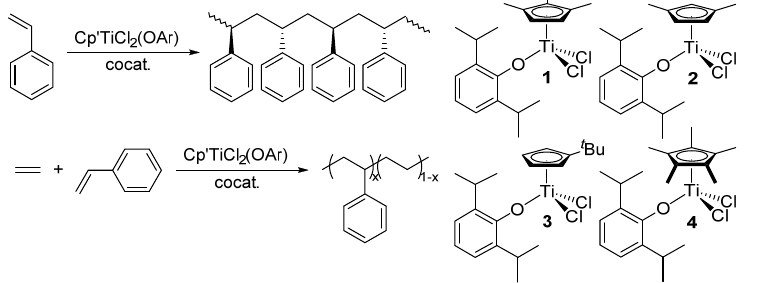
Scheme 1. Effective catalyst precursors for random ethylene/styrene copolymerization